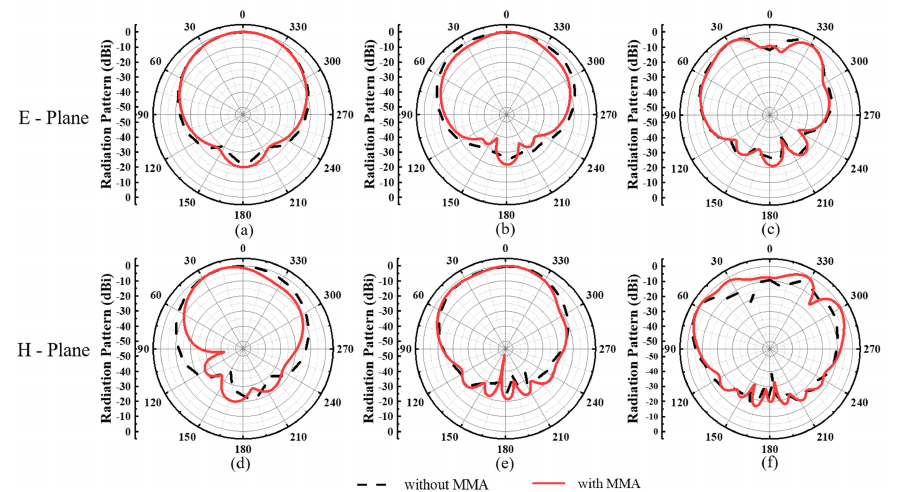
Figure 4. Simulated radiation patterns of the normalized amplitude of the transceiver antenna with and without the MMA. ( a – c ) E-plane and ( d – f ) H-plane at 1.0 GHz, 2.0 GHz,3.0 GHz, respectively.